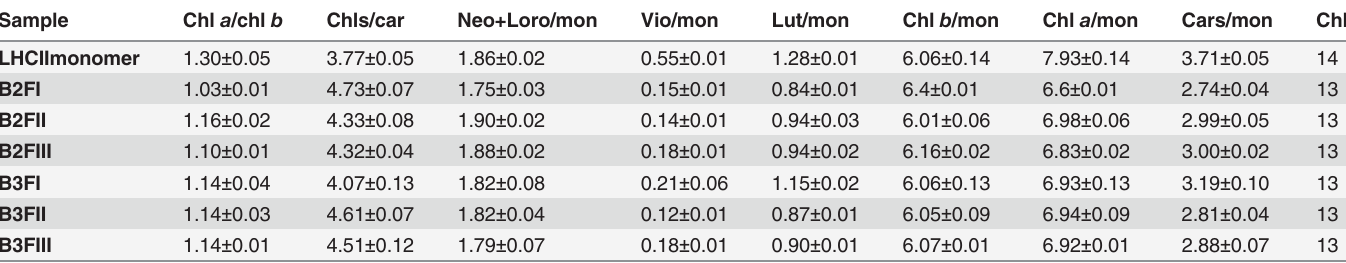
The data are the results of three pigment extraction replicas.